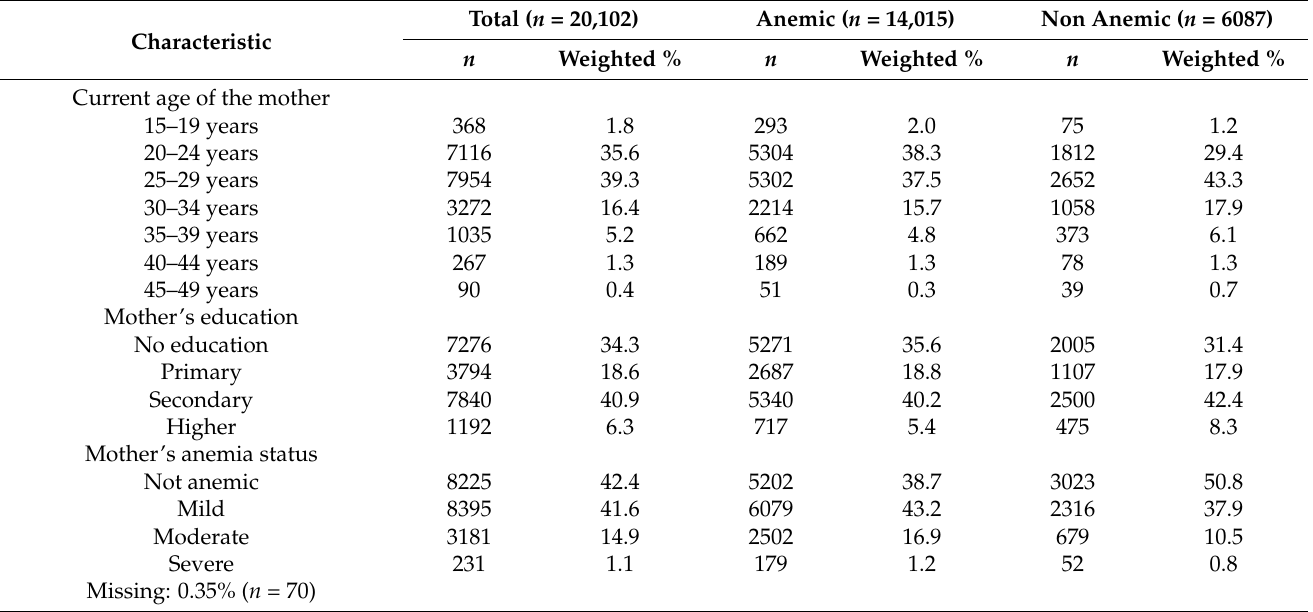
Table 1. Demographics and household characteristics of children under aged 6–59 months in Madhya Pradesh by anemia